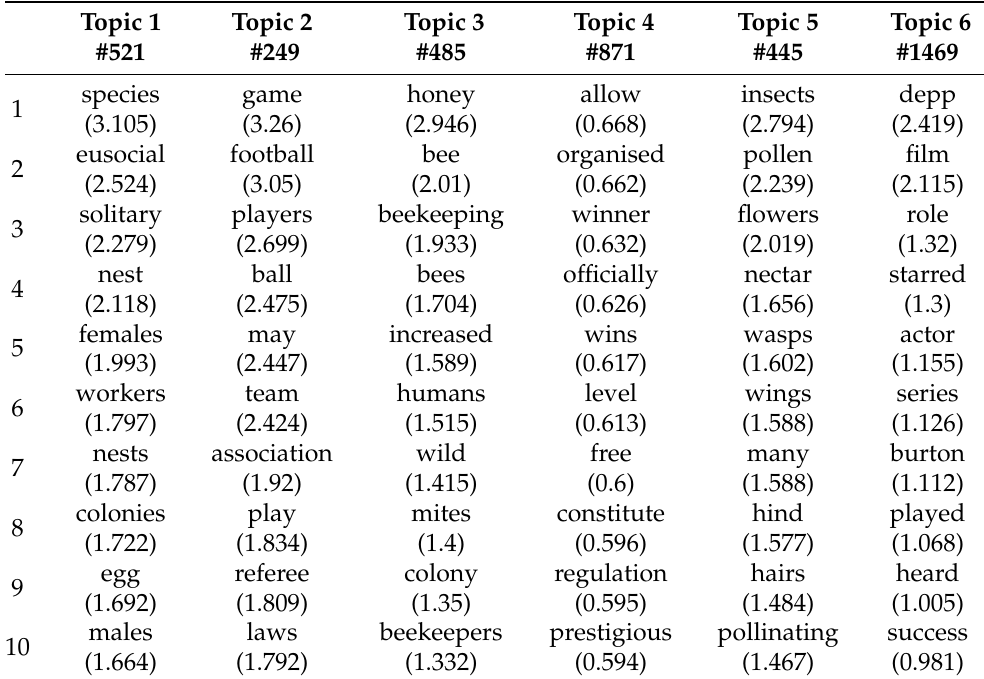
Table 8. Top 10 representative words per dimension of the basis matrix A , trained on the wikipedia data as input tensor using multiplicative update